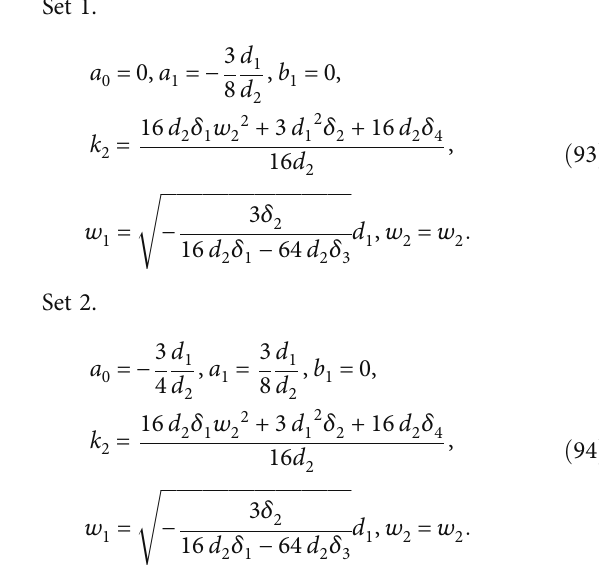
Figure 5: The graphical simulation representation of j U 3 0 : 1, δ = 0 : 6 4